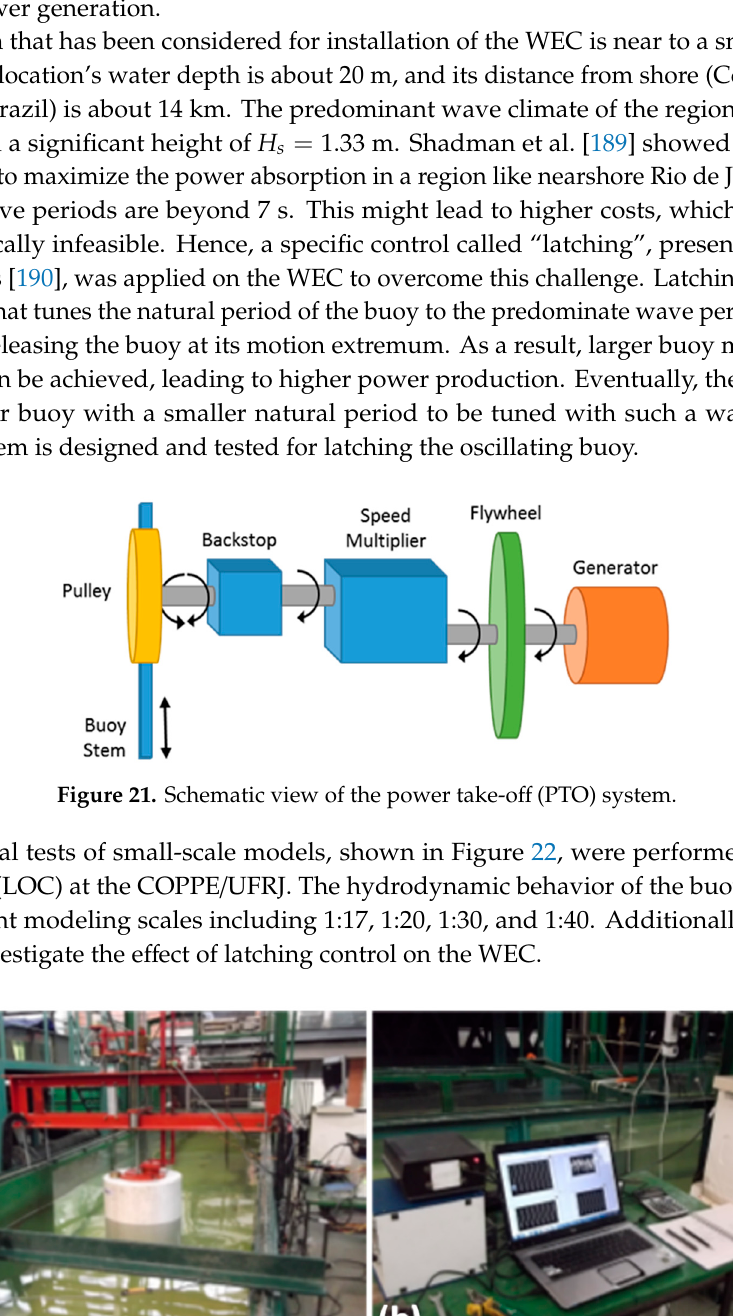
Figure 22. Experimental tests of the COPPE nearshore WEC in a wave channel: ( a ) 1:17 scaled model, ( b ) instruments for data acquisition.